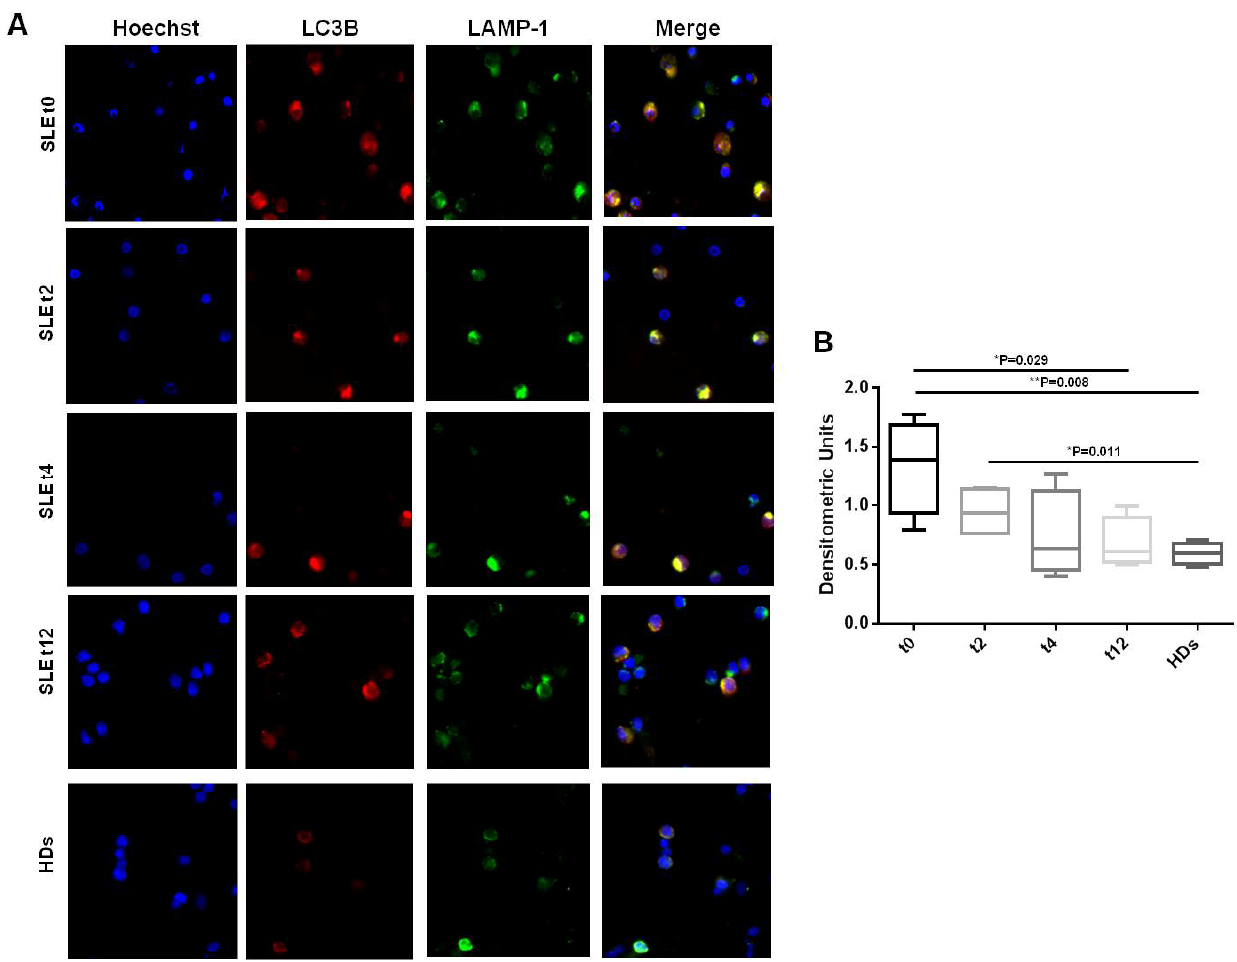
Figure 3. Immunofluorescence analysis of LC3B and LAMP-1 localization in PBMCs from SLE patients and HDs. A representative image of LC3B expression as LC3 puncta (red fluorescence) and LAMP-1 expression (green fluorescence) in Triton-X-100-permeated cells. PBMCs from SLE patients at ( A ) baseline (t0) and after 2, 4, and 12 weeks (t2, t4 and t12) of belimumab administration, and from HDs. Results from a representative experiment are shown. Cells were stained with Hoechst dye to reveal nuclei (blue staining). The yellow spots indicate colocalization (merge) of the two markers in autophagic cells. A diffuse cytoplasm staining with virtually no puncta is visible at t0 and t2, while at t4 and t12, a typical punctate staining is observable, more similar to that of the HDs, in which rare yellow spots (autophagic vacuoles) are present. Magnification: 50X. ( B ) Quan- tification by densitometric evaluation of LC3B and LAMP-1 colocalization (merge yellow spots) from positive cells, as resulting from immunofluorescent staining for each condition in 3 inde- pendent experiments. In PBMCs from SLE patients, reductions at all of the timepoints and signifi- cant differences with respect to HDs were observed (* p = 0.029 t0 vs. t12, ** p = 0.008 t0 vs. HDs; * p = 0.011 t2 vs. HDs). Results are represented as the mean ± standard deviation (SD) of densitometric units.